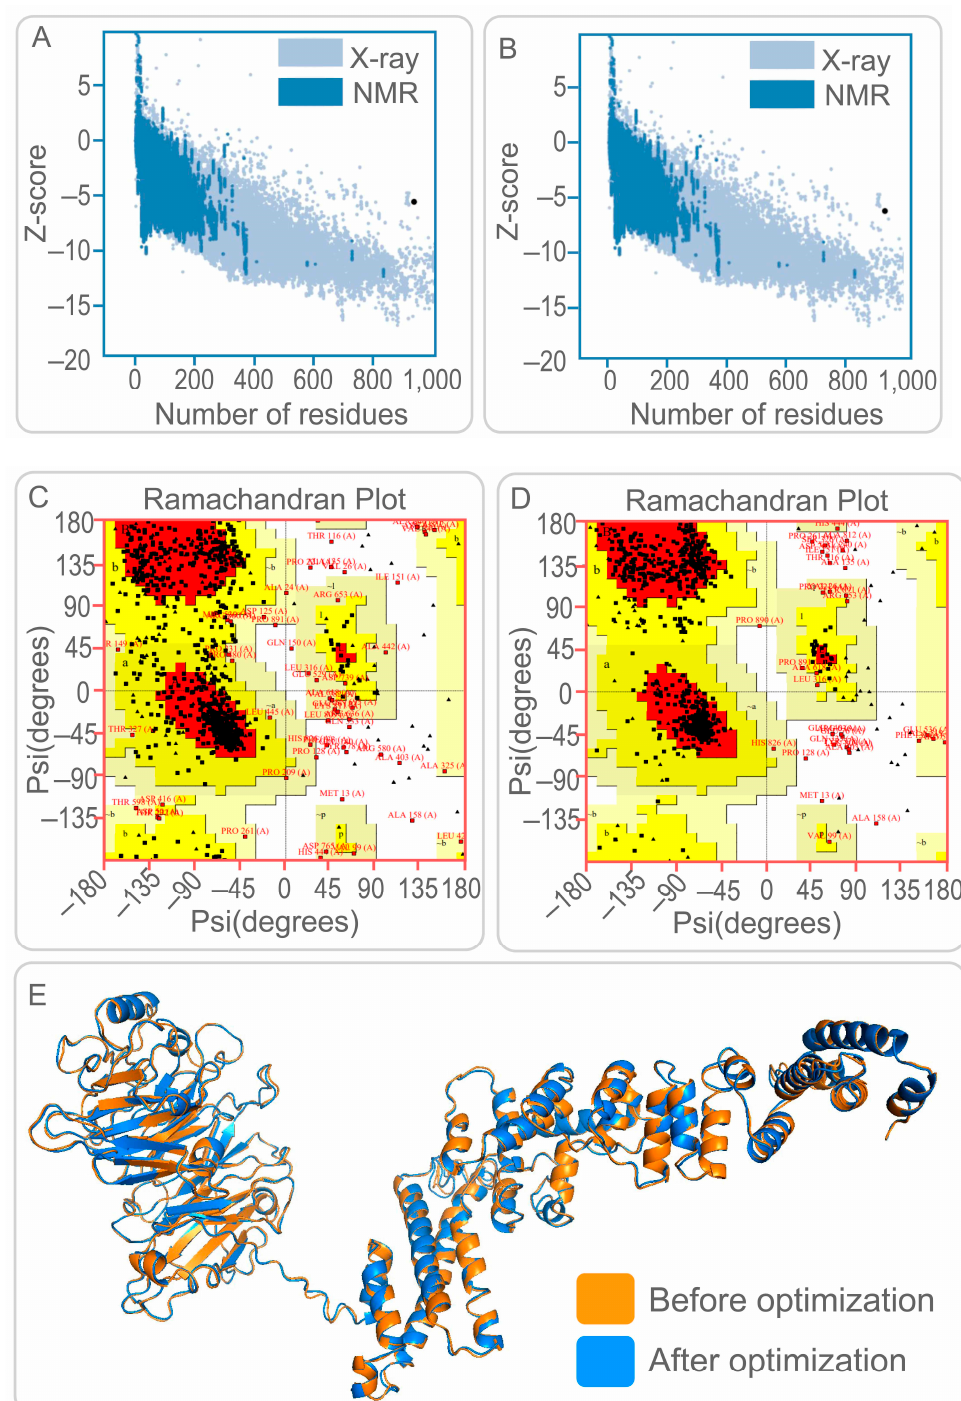
Figure 2. Construction and optimization of 3D models for PP19128R vaccine. ( A , B ) Z-score of the PP19128R vaccine predicted by ProSA web server. The Z-score of the 3D model of the PP19128R vaccine was − 5.59 before optimization ( A ) and − 6.28 after optimization ( B ). ( C , D ) Ramachandran plot of the PP19128R vaccine predicted by UCLA-DOE LAB-SAVES v6.0 server. The core, allow, gener, and disall of the PP19128R vaccine were 70.8%, 22.8%, 4.4%, and 2.0% before optimization ( C ) and 87.2%, 9.0%, 1.6%, and 2.2% after optimization ( D ). ( E ) The 3D structure of the PP19128R vaccine was constructed by the I-TASSER server and optimized by the Galaxy Refine server. Before optimization: orange; after optimization: